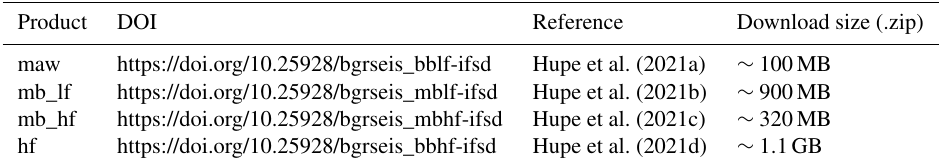
Figure 12. Similar to Fig. 11 but for the hf product (1–3Hz). Table 2. DOIs and references related to the infrasound products. The file sizes refer to the 2003–2020 data sets and will increase when more years are added to the .zip